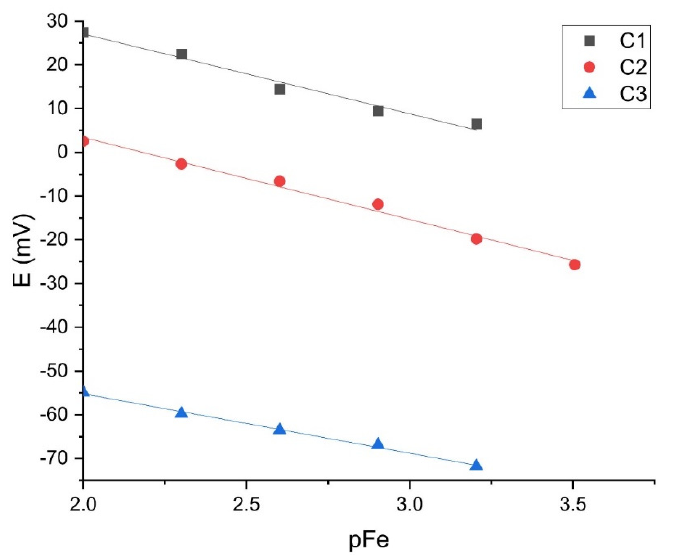
Figure 9. Results obtained for Fe3+ cation determination in ferric nitrate solution using the M1 sensor. Table 3. Results of testing M2–M15 membranes in EB1 towards ferric cations.